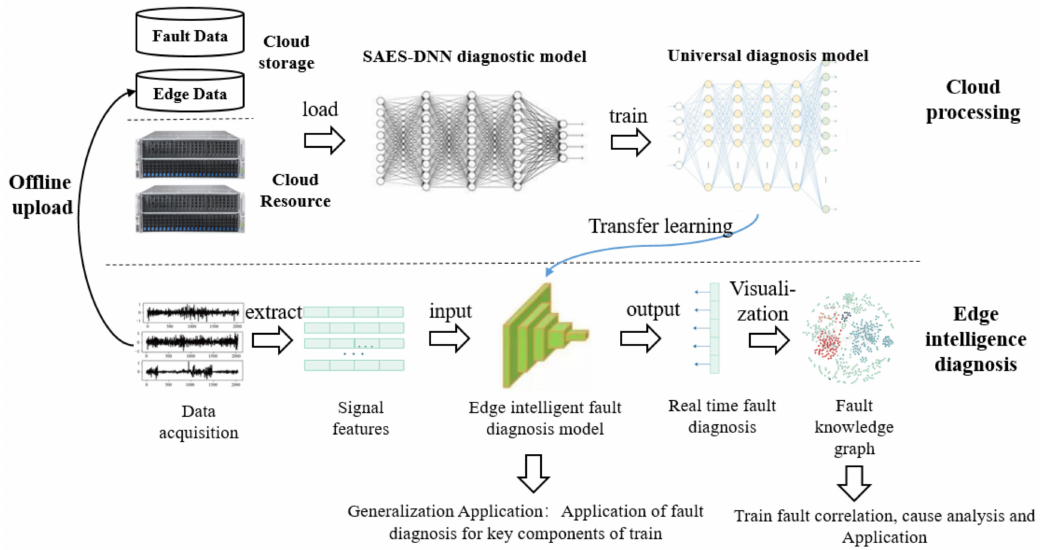
Figure 1. Framework of the train fault diagnosis model, which consists of cloud and intelligent edge computing. The cloud trains the fault detection model and transplants the trained model to the edge through transfer learning. The edge end collects the signal data in the process of train operation and uses the edge fault detection model for real-time fault identification.